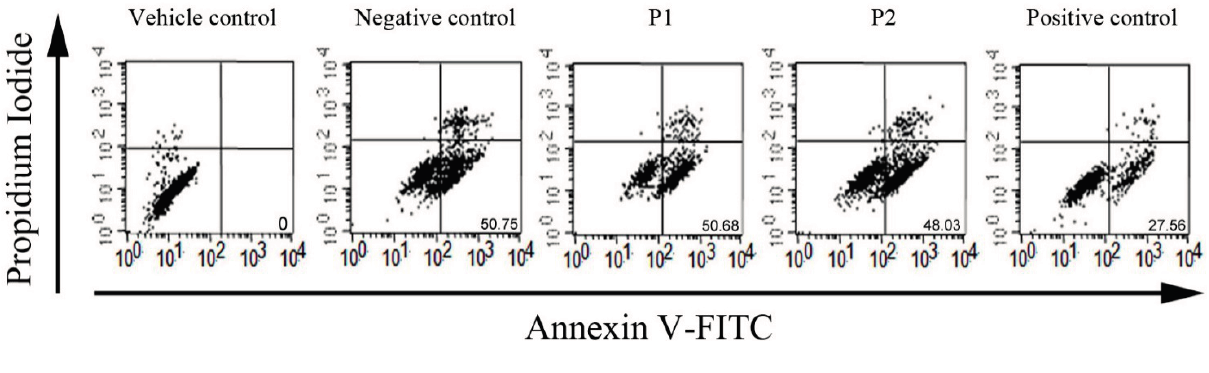
O . Then apoptosis 2 2